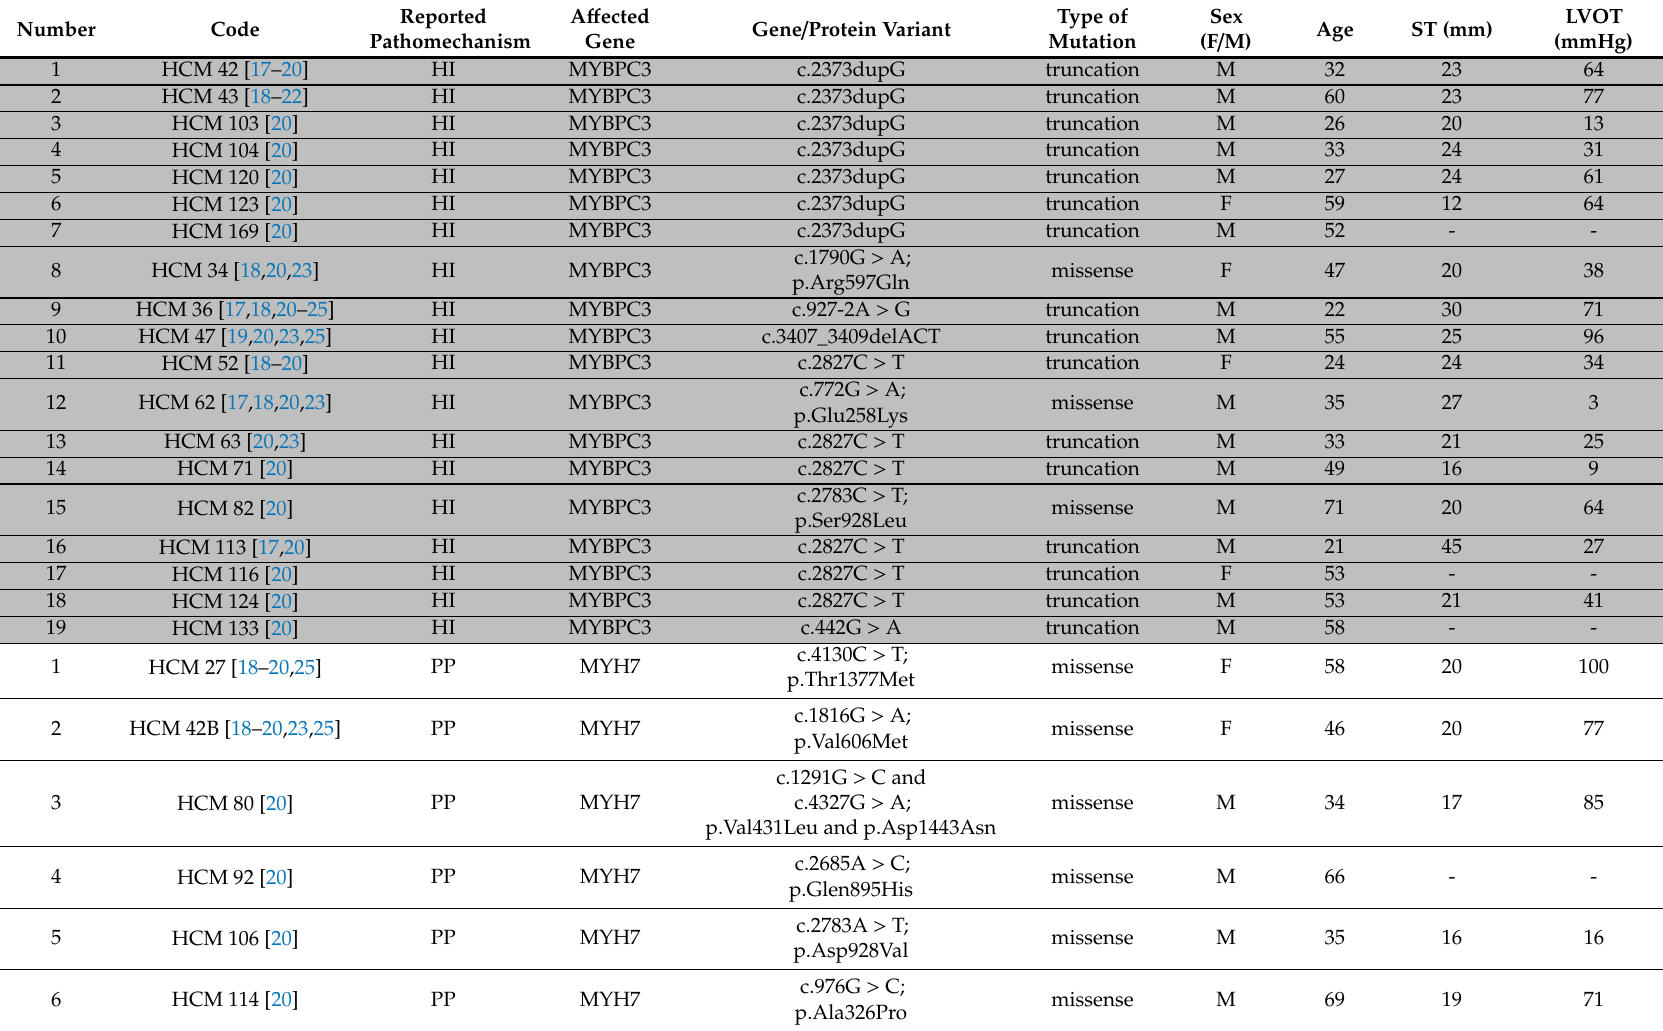
Table 1. Characteristics of controls and manifest HCM